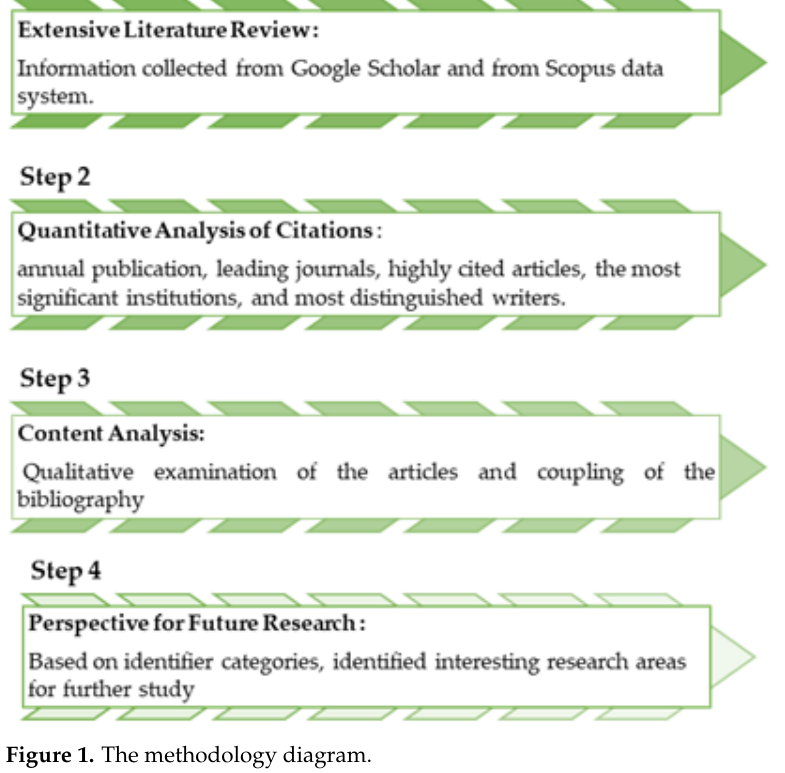
Figure 1. The methodology